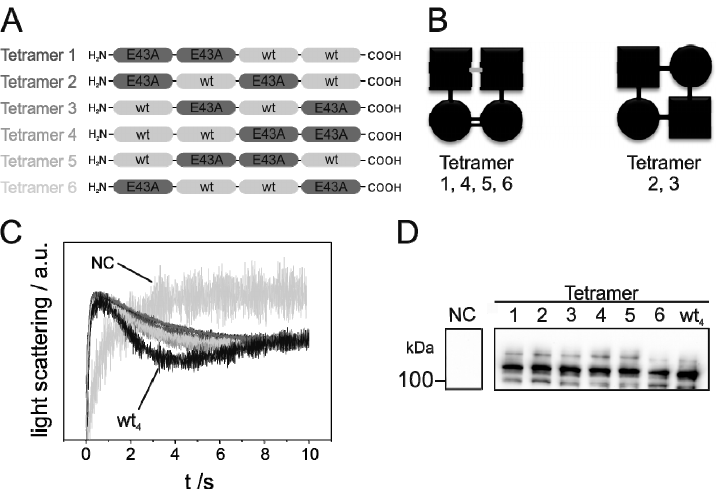
Figure 5. Activity of genetically fused GlpF heterotetramers containing two mutated protomers at different positions. ( A ) Schematic representation of the fused WT 2 /EA 2 permutations. The light gray and dark gray boxes represent WT and E43A ‐ mutated GlpF, respectively. ( B ) Schematic depiction of interactions between individual GlpF monomers, with WT protomers having the strongest interactions ( = ), followed by weaker interactions between a WT and a mutated protomer ( ‐ ) and weakest interactions between two mutated monomers ( ‐ ). ( C ) Typical light ‐ scattering curves of the fused GlpF tetramers (different gray tones: compare ( A )) and WT 4 (black) after induction of protein expression with 500 μ M IPTG. GlpF ‐ free control cells (NC) (gray) were transformed with the plasmid pMalp2 and treated exactly as protein ‐ expressing cells. The light ‐ scattering curves are an average of five measurements. ( D ) Western blot analysis, determining the expression level of the studied permutated GlpF heterooligomers as well as the fused GlpF WT homooligomer (WT 4 ). For the Western blot analysis, an antibody recognizing the GlpF C ‐ terminus was used. See also Figure S4.